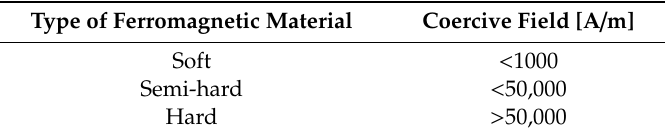
Table 1. Classification of ferromagnetic material [12].